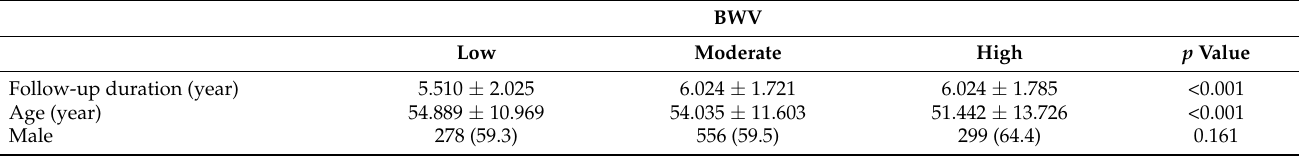
Table 1. Baseline characteristics of study participants by